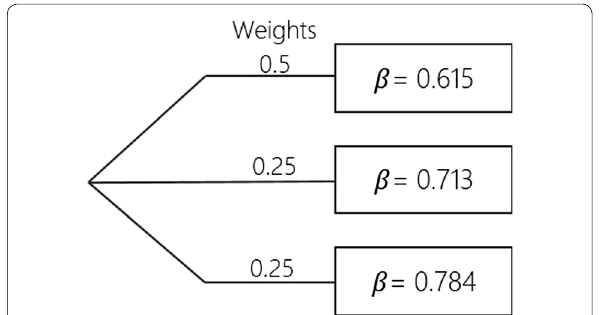
Fig. 5 Schematic of a logic-tree approach to incorporate the standard deviation of log-normal distribution,